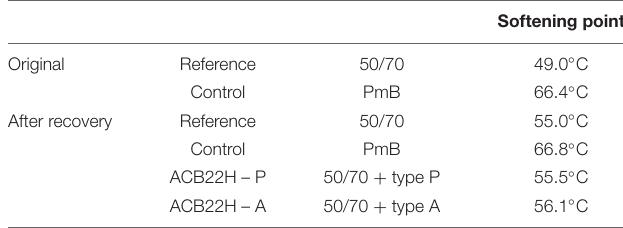
Frontiers in Built Environment |